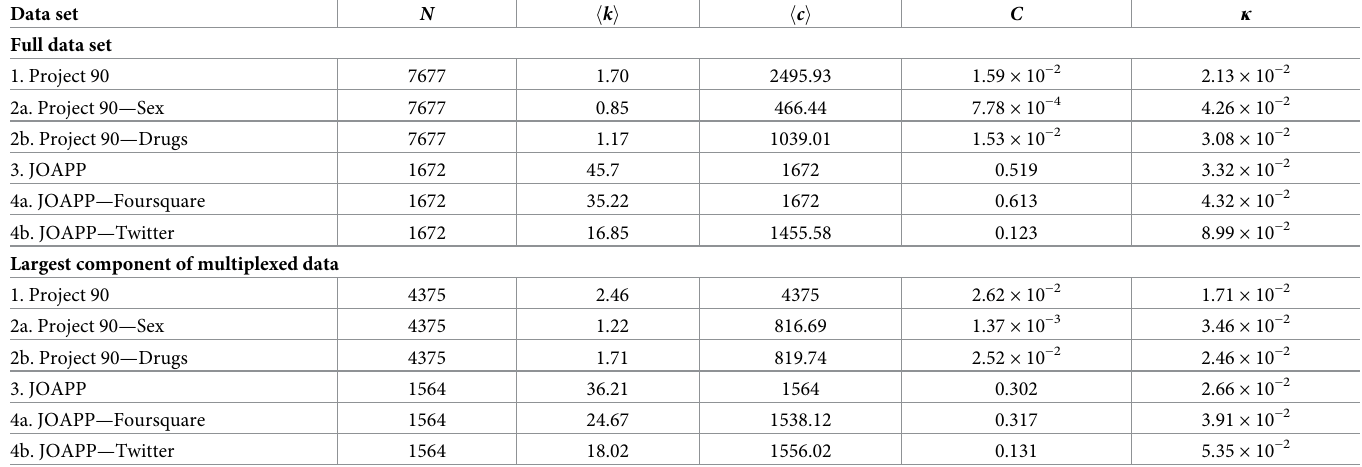
Table 1. Statistics of the chosen networks. Data set Full data